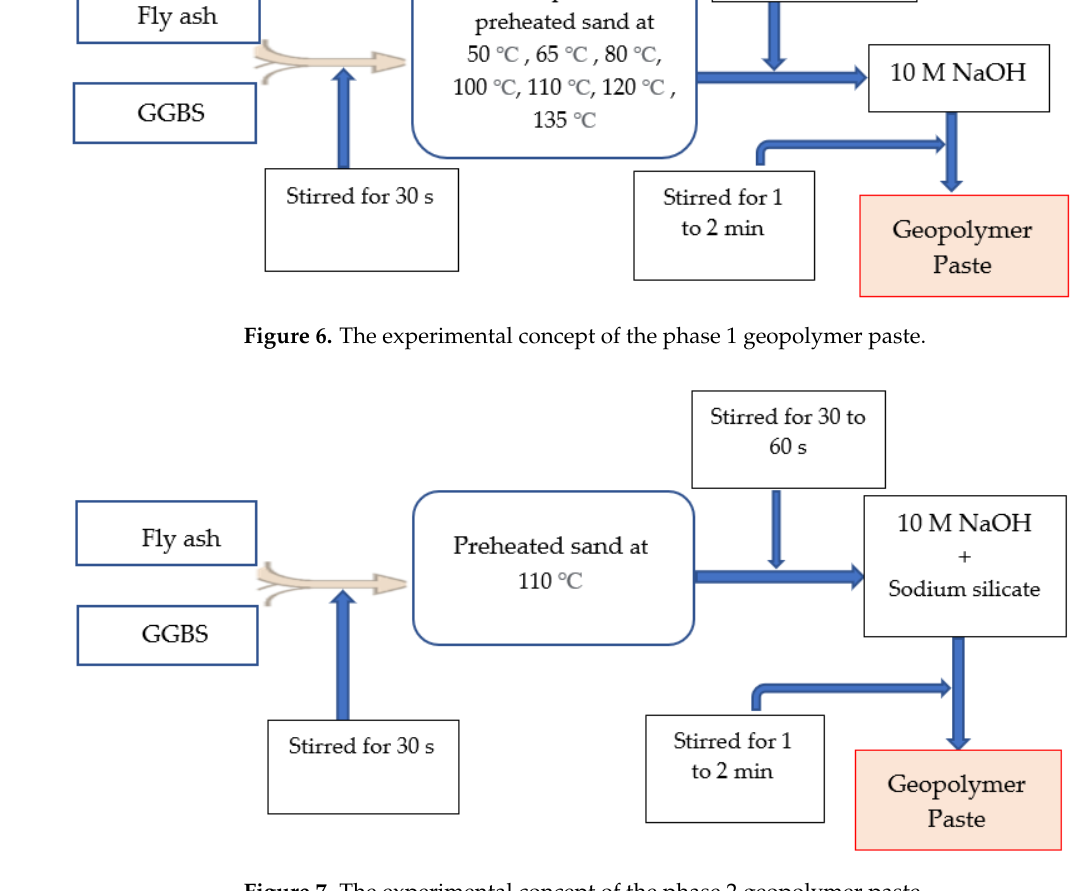
Figure 7 . The experimental concept of the phase 2 geopolymer paste.